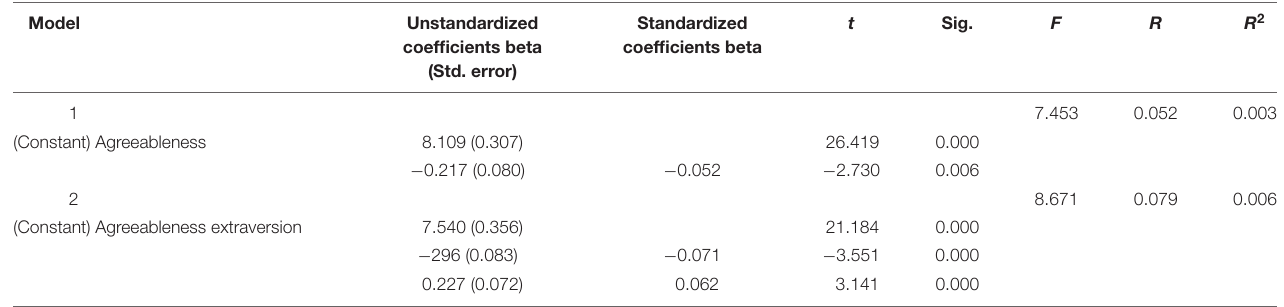
TABLE 8 | Stepwise multiple regression to find out the effects of personality traits on higher achievers’ students.